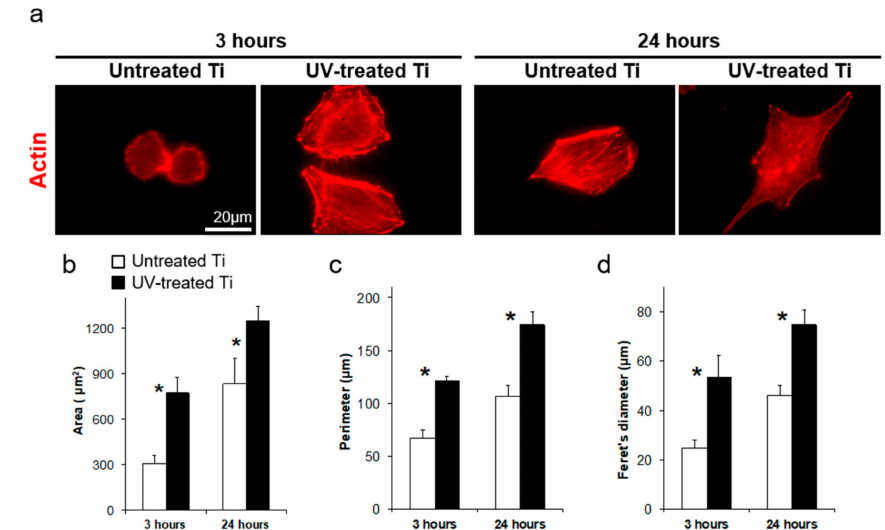
Figure 3. Cytomorphometry of osteoblasts on the titanium surfaces. ( a ) Representative images of initial cell spreading and cytoskeletal development during culturing on the untreated control and UV-treated titanium surfaces after 3 and 24 h of culture. The cell actin was stained with rhodamine phalloidin (red). Scale bar = 20 µ m. ( b – d ) Bar graphs show the cell morphometric evaluation for cell area, perimeter, and Feret’s diameter (maximum diameter) (* p <